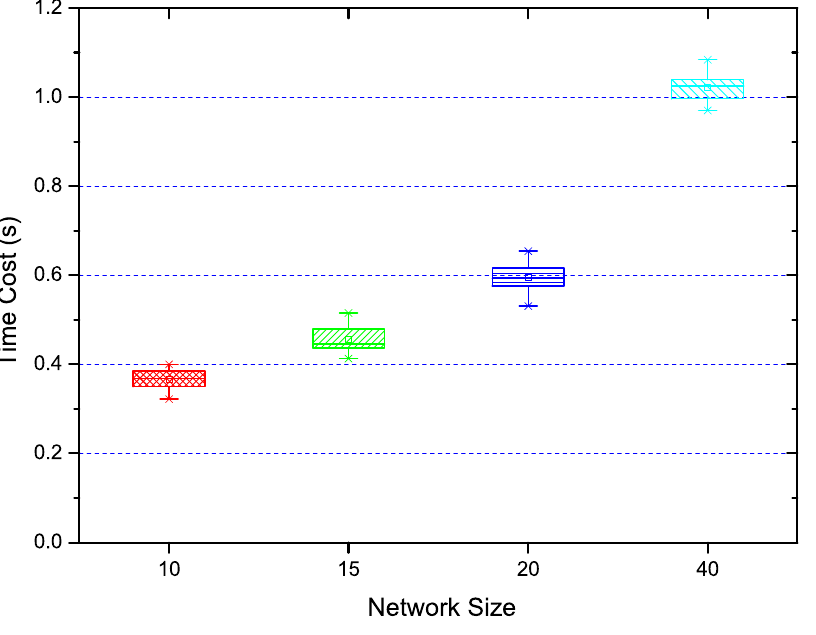
Figure 3. The time cost to conduct our algorithms in scenarios with different network